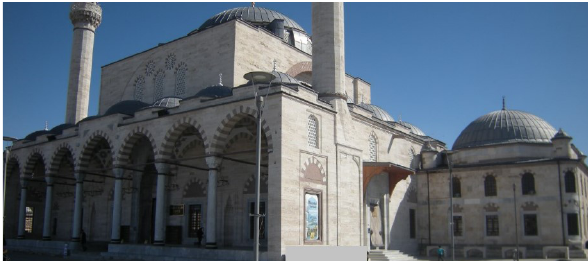
Figure 1. From Nort side visualization of Sultan Selim Mosque (left) and Yusuf Aga Library (right)